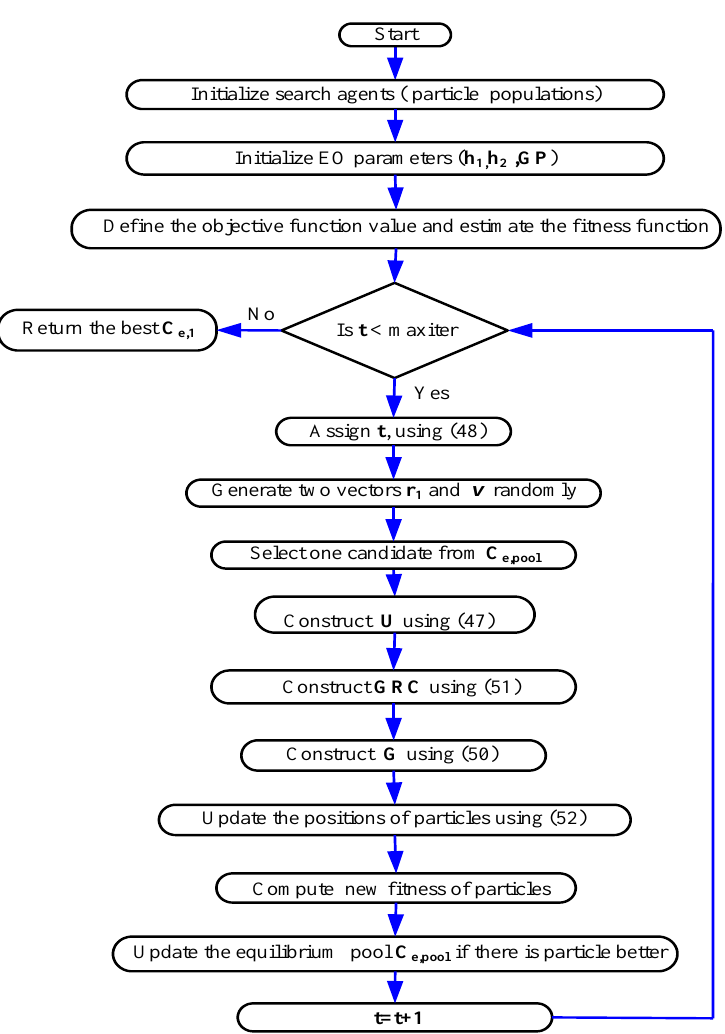
Figure 2. Flowchart of the equilibrium optimizer (EO) algorithm.